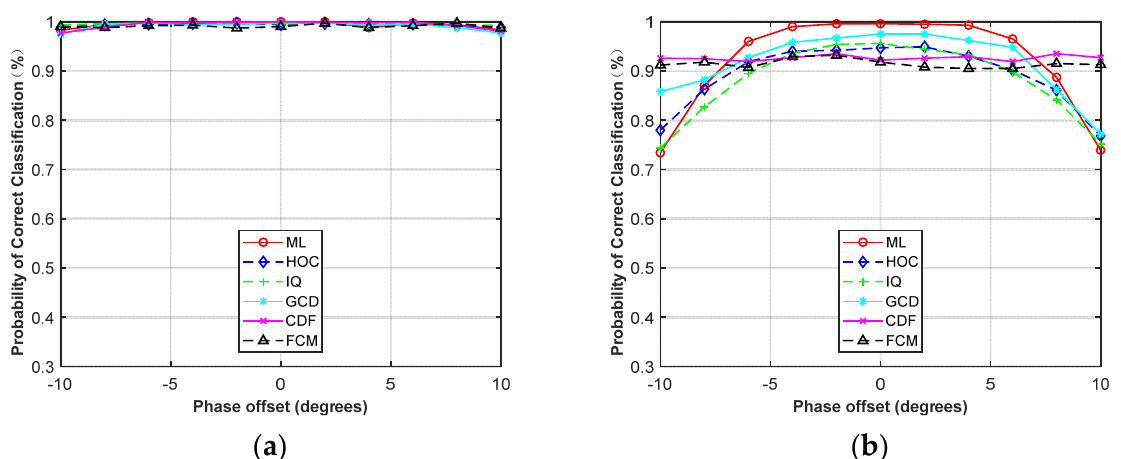
Figure 9. Probability of correct classification versus phase offset. ( a ) MPSK (SNR = 6, N = 128). ( b ) MQAM (SNR = 10, N = 512).